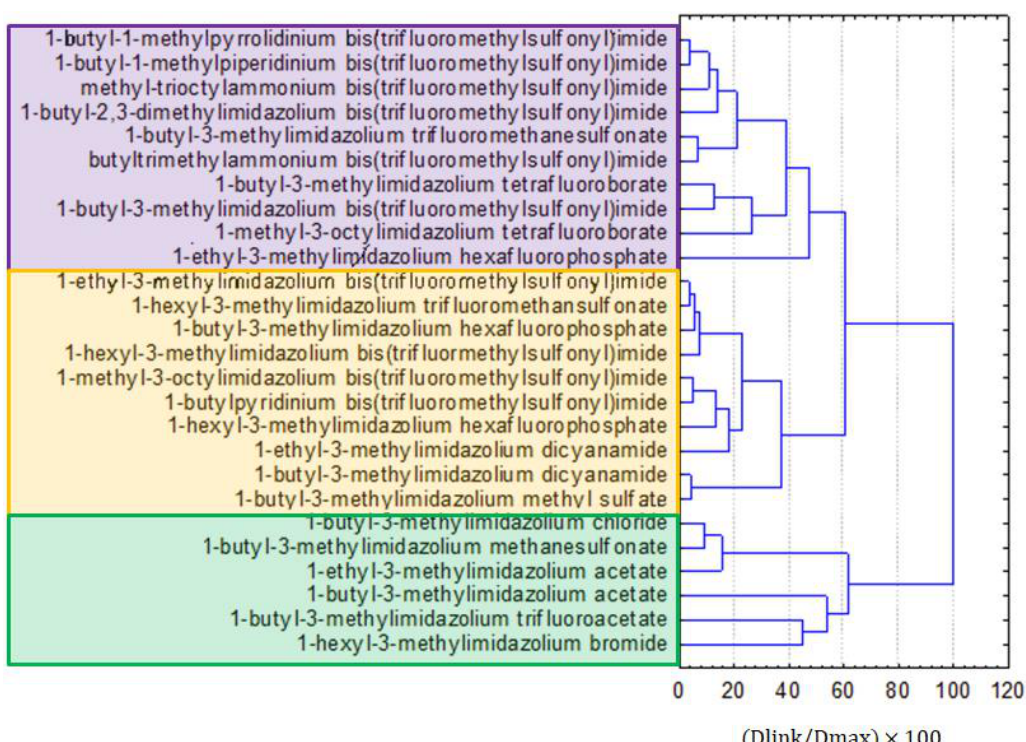
Figure 5. The hierarchical dendrogram for the linkage of 26 ILs.